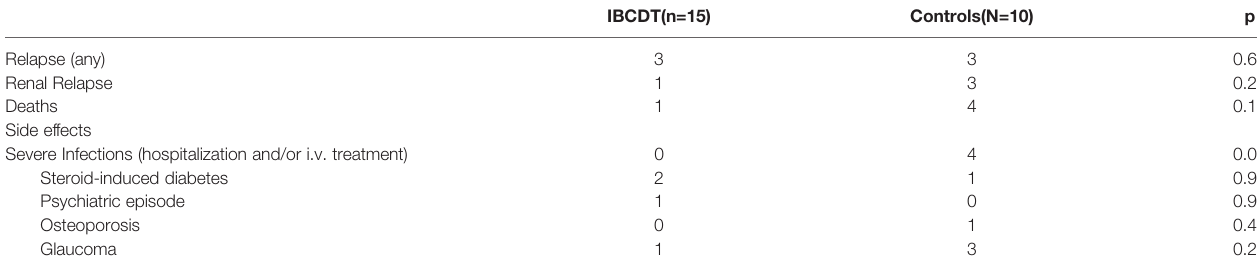
TABLE 5 | Comparison of overall safety and ef fi cacy pro fi le at the end of follow-up.